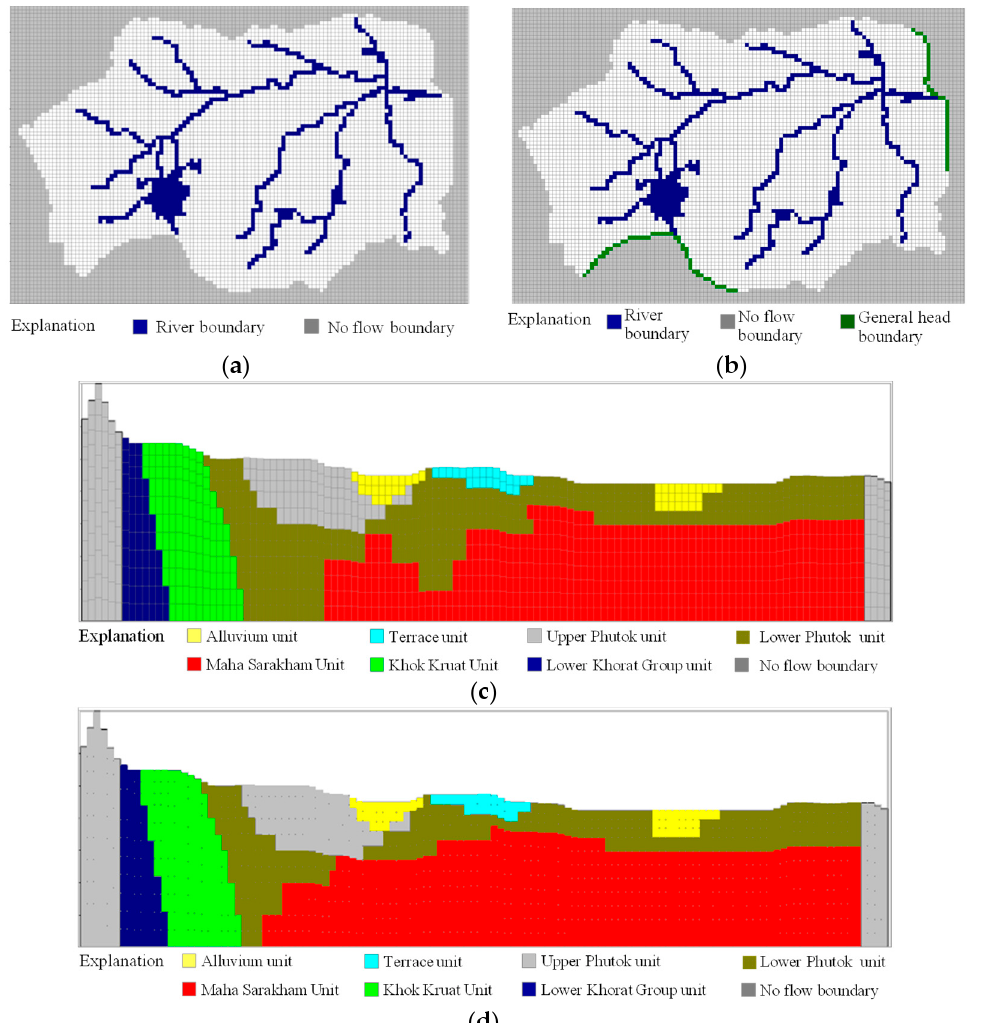
Figure 10. Grid design and boundary conditions under alternative hydrogeological conceptual models. ( a ) Lateral flow boundary condition of models A and B; ( b ) Lateral flow boundary condition of models C and D; ( c ) Aquifer properties zones of models A and C; ( d ) Aquifer properties zones of models B and D.